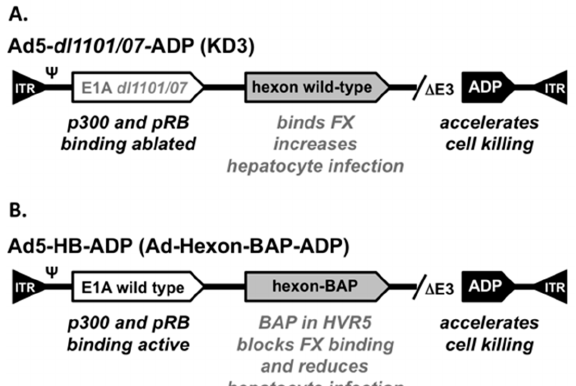
Figure 1. Cartoon of Adenovirus Aerotype 5 (Ad5) Vectors. ( A ) Functional features in Ad5- dl 1101/07-ADP (see text); ( B ) Functional features in Ad5-HB-ADP (see text).